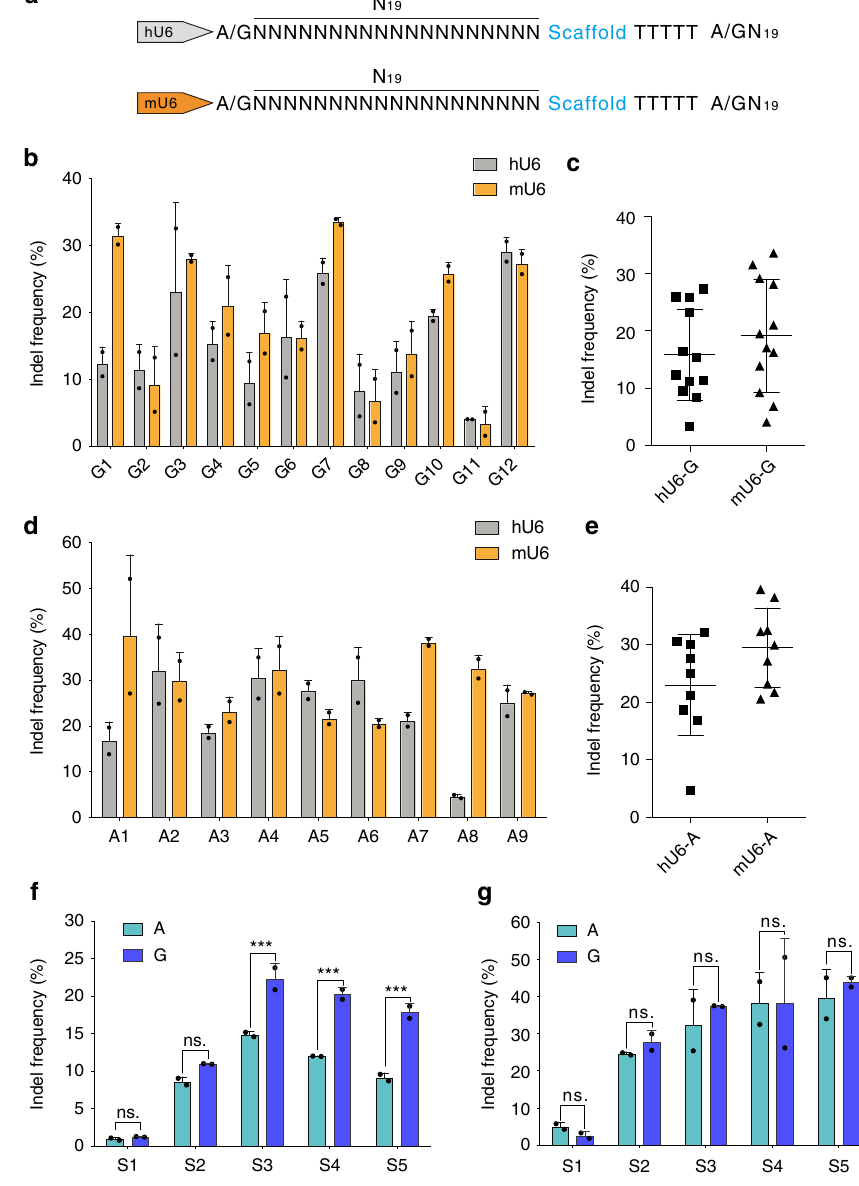
Fig. 1 Both mU6 promoter and hU6 promoter enable to transcript gRNAs initiated with A or G for genome editing. a Schematic diagram of mU6 and hU6 comparison. These two promoters were used to transcript gRNAs initiated with A or G nucleotide. b , c Comparison of mU6 and hU6 promoters for genome editing with gRNAs initiated with G. The data are shown as mean ± s.d. ( n = 2). d , e Comparison of mU6 promoter for genome editing with gRNAs initiated with A. The data are shown as mean ± s.d. ( n = 2). f Comparison of the mU6 promoter for genome editing with gRNAs initiated with A or G three days post transfection. g Comparison of the mU6 promoter for genome editing with gRNAs initiated with A or G 5 days post transfection. The data are shown as mean ± s.d. P > 0.05; P < 0.05 by two-way ANOVA ( n = 2). Source data are provided as a Source Data fi